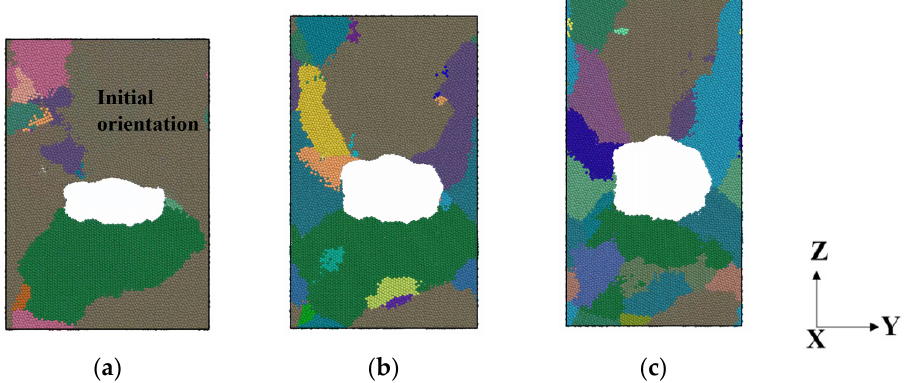
Figure 5. Atomic slices of the system with 1 precipitate in stage IV, (colored according to different orientations; gray represents the initial orientation) ( a ) at strain 0.268; ( b ) at strain 0.390; ( c ) at strain 0.460.